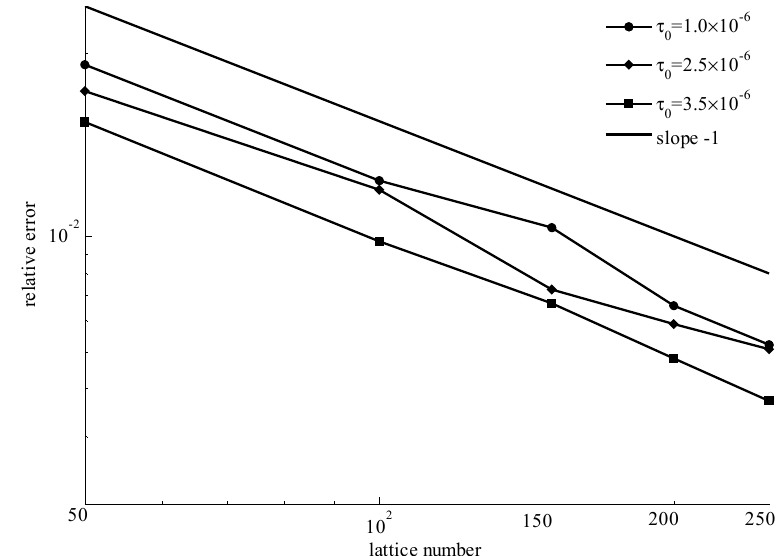
Figure 8. Relative errors for n = 1 with different initial yielding stresses and lattice numbers.